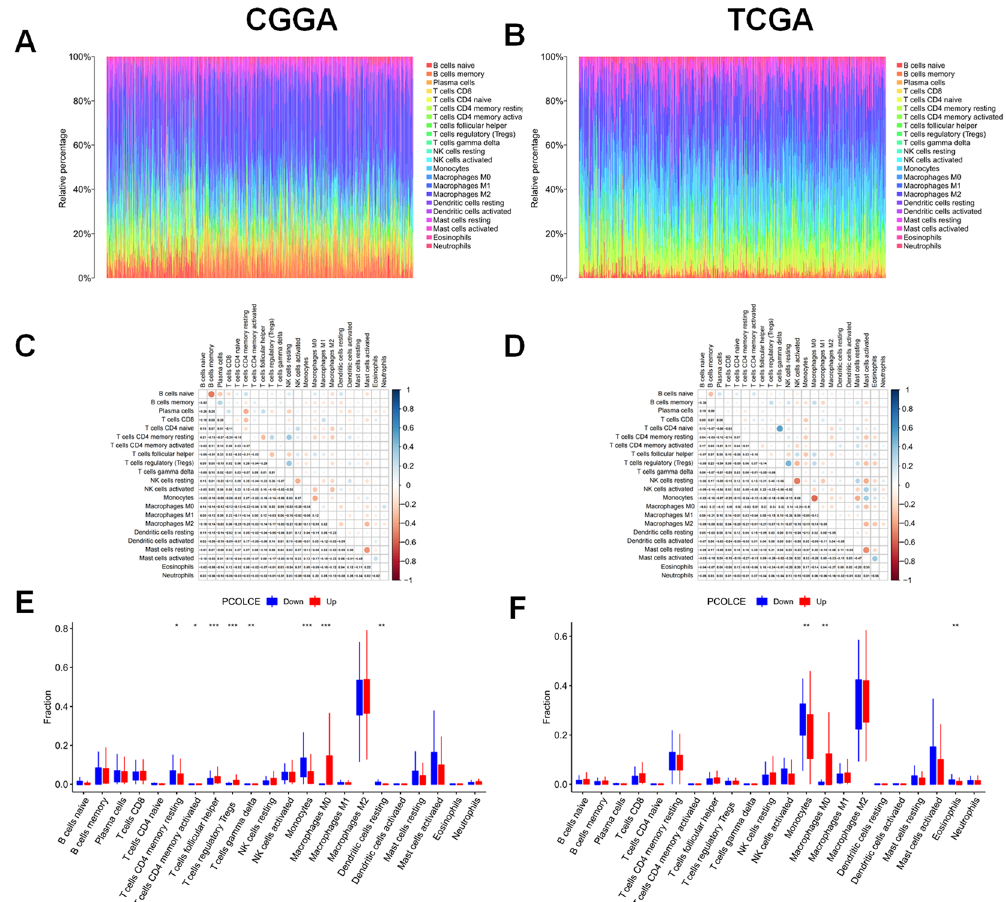
Figure 7. Presence and subtypes of immune cell infiltrates. The proportion of immune cells in each glioma sample is represented by a different color, and the bar lengths represent the immune cell population levels ( A , B ). The proportional correlation matrix of all 22 immune cells. Negatively correlated (blue); positively correlated (red). The darker the color, the higher the correlation in gliomas( C , D ). Proportions of the 22 types of tumor- infiltrated immune cells in different PCOLCE expression groups( E , F ). *P < 0.05; **P < 0.01; ***P <